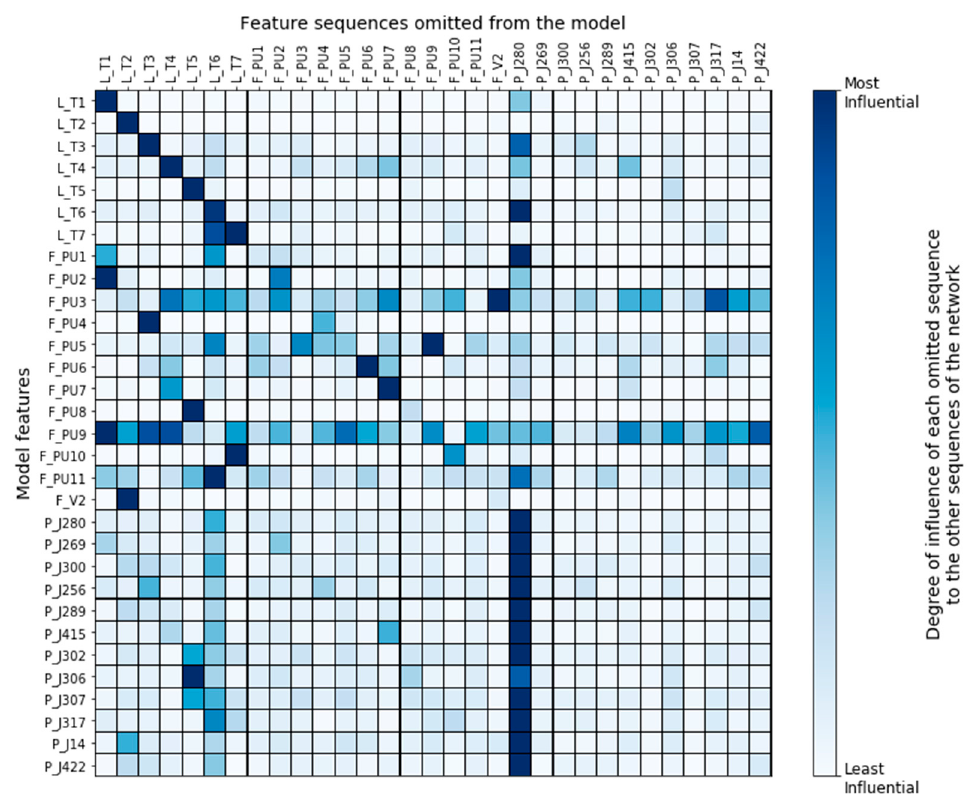
Figure 9. Node-level summary of the impact each feature has on the other features of the